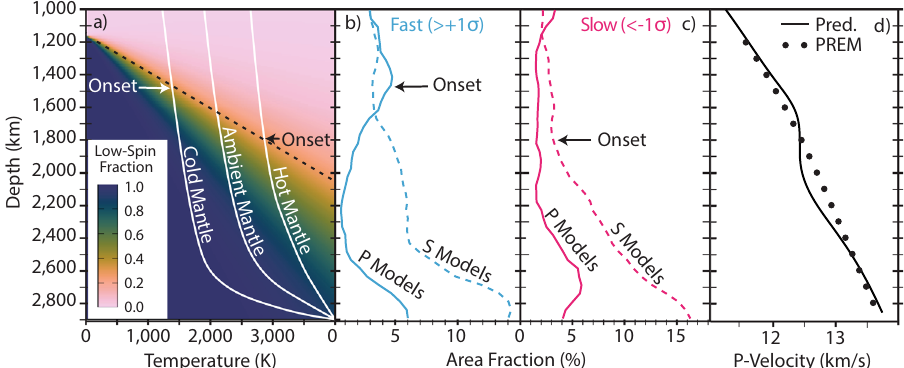
Fig. 1 Comparison of mineral physics predictions and seismological observations of the Fe spin crossover in Fp. a The depth-temperature distribution of low-spin Fe and three schematic mantle geotherms. The onset of the mixed-spin region occurs at shallower depths for relatively colder temperatures and at greater depths and over a broader range at higher temperatures. Surface area of fast ( b ) and slow ( c ) velocities in the lower mantle imaged by unanimous consensus (4/4 models) corresponding to the vote maps shown in Figs. 5 and 6. A divergence in the seismic signal between P-wave models relative to S-wave models is revealed below the respective "onset'' depths of ~1400 and 1800 km. d The calculated pro fi le of P-wave velocities for pyrolite 15 (see Supplementary Fig. 9) reveals a signi fi cant departure suggesting that the signature of the spin crossover is not a globally averaged feature. See Methods. Colour gradients from ref. 73